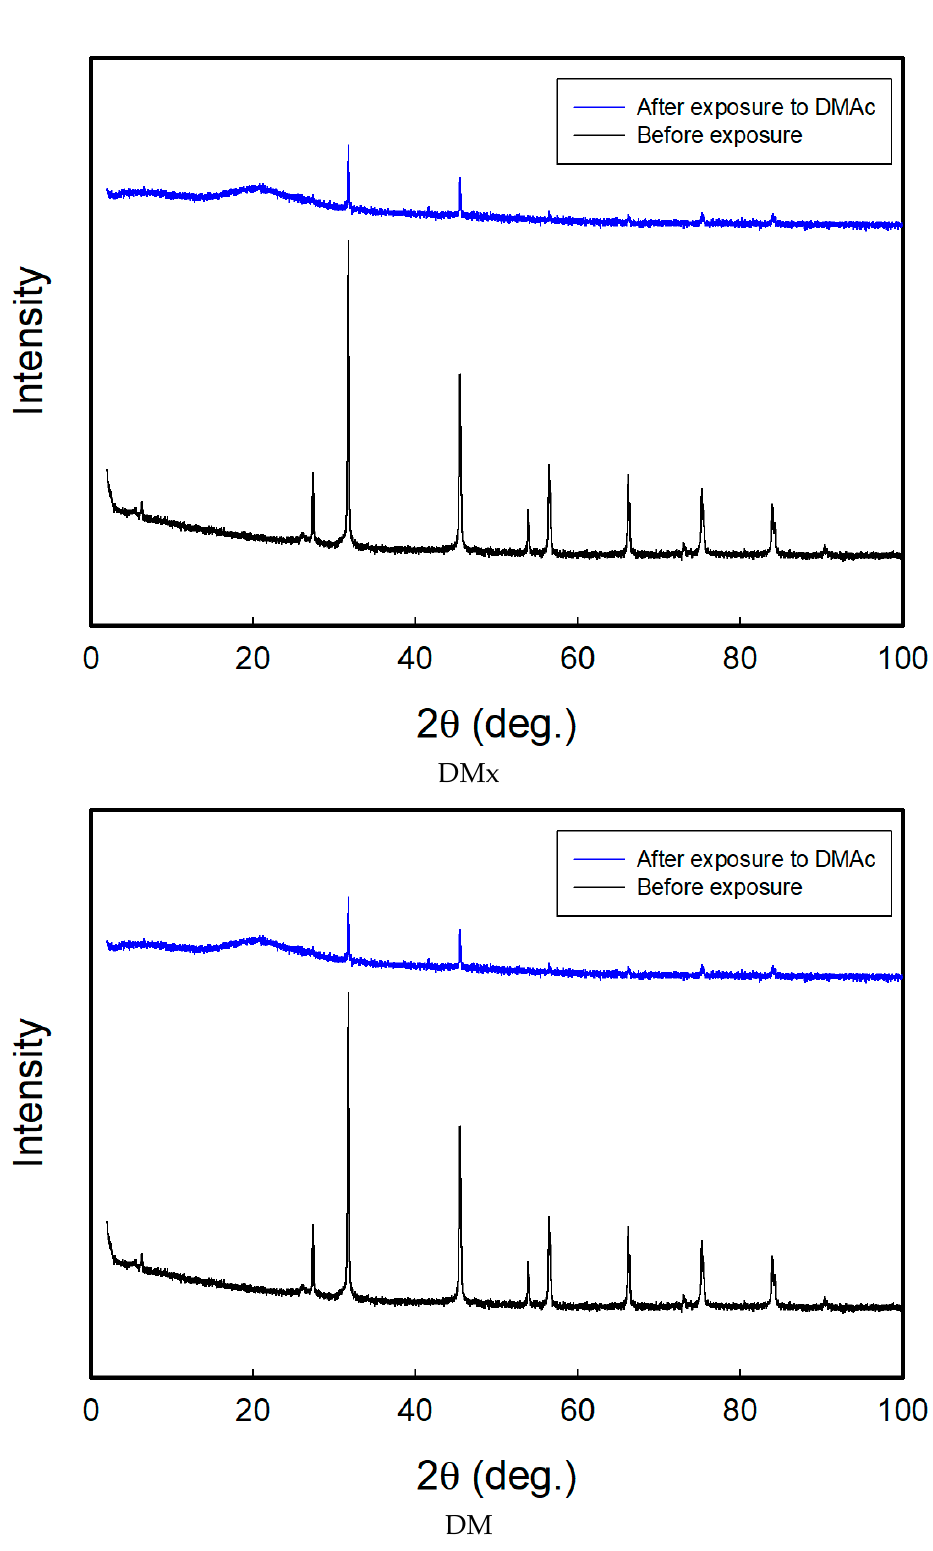
Figure 9. XRD patterns of DMx and DM before and after exposure to DMAc.